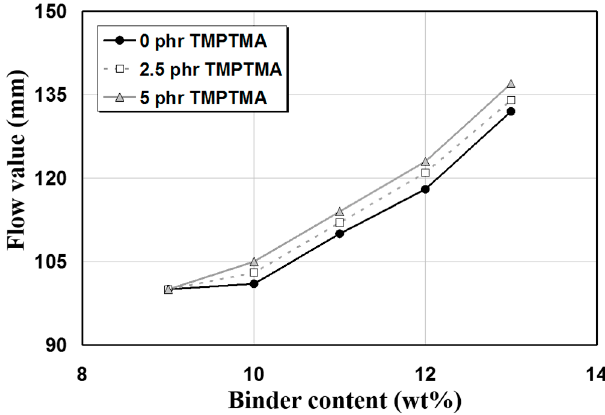
Figure 2. Effects of binder and TMPTMA contents on flow value.